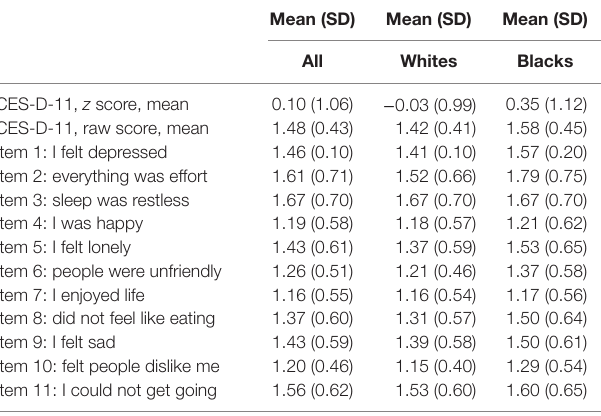
CES-D; Center for Epidemiologic Studies Depression scale.